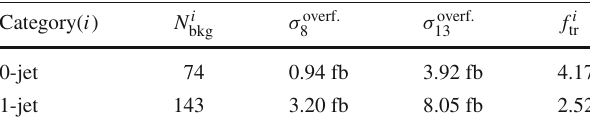
Table 4 Information necessary to estimate the 13 TeV projections of > 200 GeV overflow bins the fitted background yields, N bkg , in the p V T quotedintheanalysisofRef.[61].Weshowthe t ¯ t fiducialcrosssections after the kinematic selection of Appendix B for 8 and 13 TeV collisions and assuming a 29.2% semi-leptonic branching fraction, along with